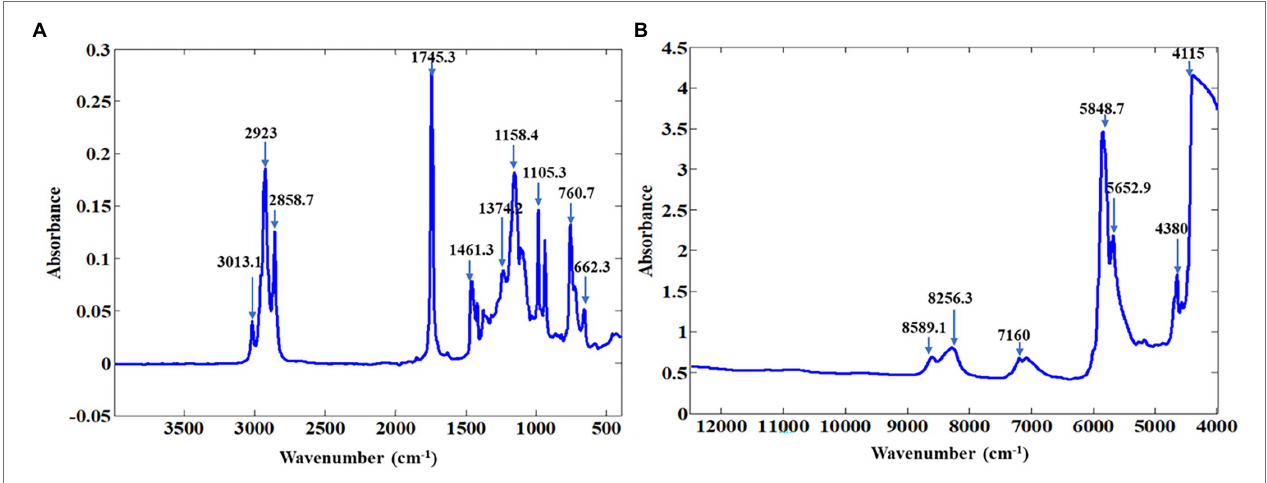
FIGURE 1 | Representative absorbance spectra for ATR-FT-MIR (A) and FT-NIR (B) of pomegranate kernel oil.